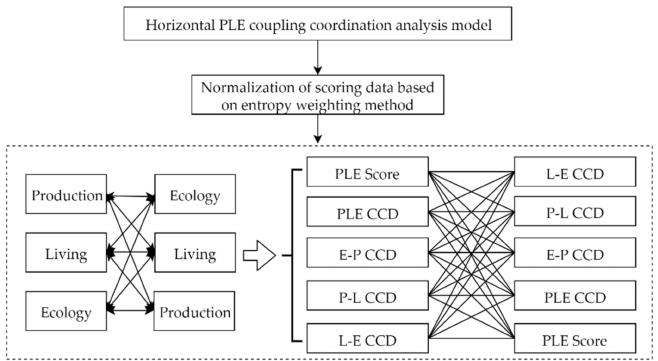
Figure 3. Process of the horizontal PLE coupling coordination